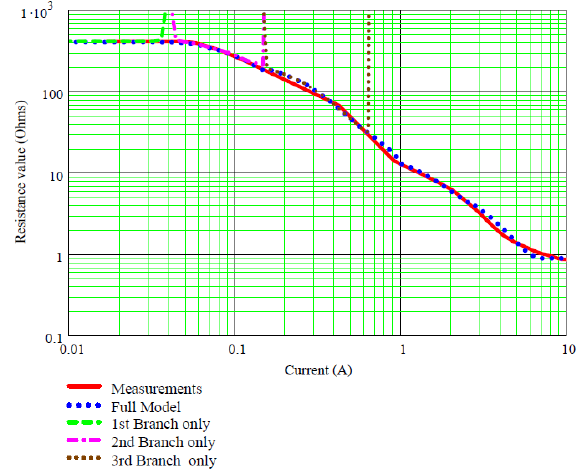
Figure 21: R(I) measured compared to model for model from Fig. 20.